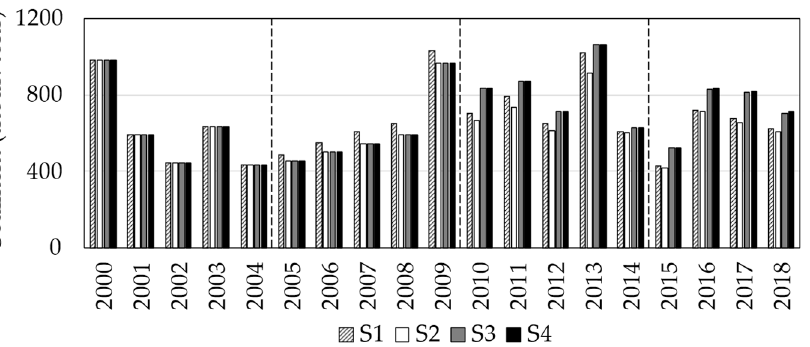
Figure 8. The differences of the total annual sediment between the different updated land- use conditions.